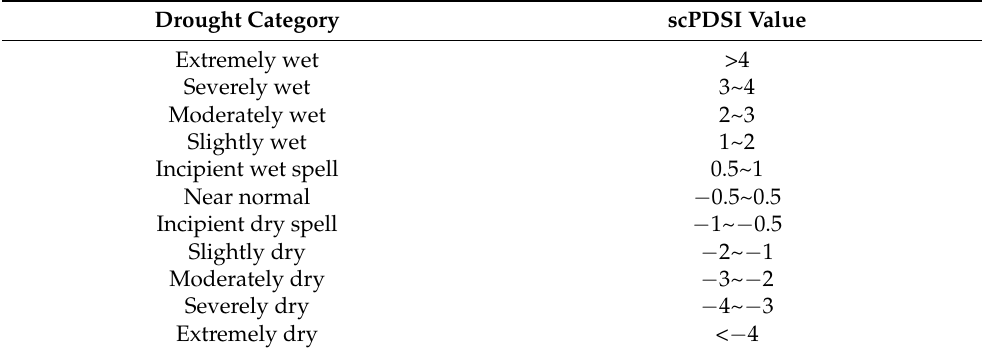
Table 2. Drought classification by self-calibrated Palmer drought severity index (scPDSI) value